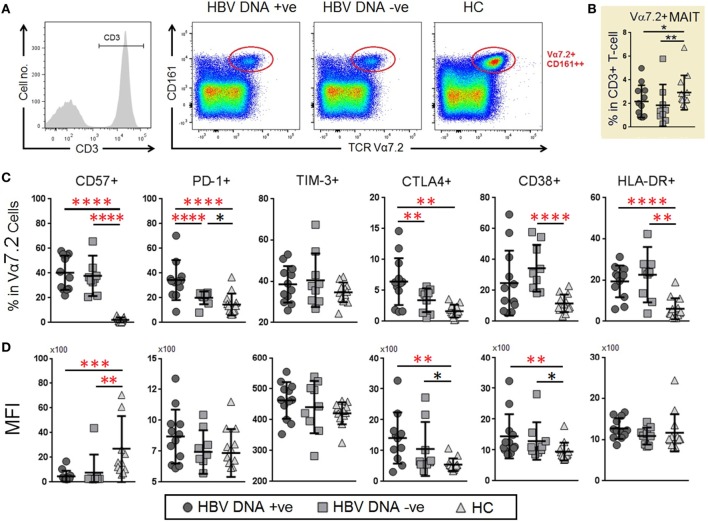
Frequencies and levels of immune senescence, exhaustion, and activation markers expressed on mucosal-associated invariant T (MAIT) cells between chronic hepatitis B virus (HBV)-infected patients with (G1, circle) and without (G2, square) HBV-DNAemia and healthy control (HC) (G3, triangle). (A) The gating strategy to identify CD3+TCR Vα7.2+ MAIT cells and Vα7.2+CD161− T cells. (B) Comparison of T cell receptor (TCR) Vα7.2+ cells frequencies across the three groups comparison of percentage. (C) Expression levels [mean fluorescence intensity (MFI)] (D) of CD57, PD-1, TIM-3, CTLA-4 CD38 and HLA-DR on TCR Vα7.2+ MAIT cells between the three patient groups. Levels of surface markers were compared across the three patient groups and post hoc Mann–Whitney U tests were then performed for those biomarkers with a Kruskal–Wallis test P value of <0.05 (*P < 0.05, **<0.01, ***<0.001, and ****<0.0001). P-values remained significant after Benjamini–Hochberg correction of multiple comparisons (marked in red*).